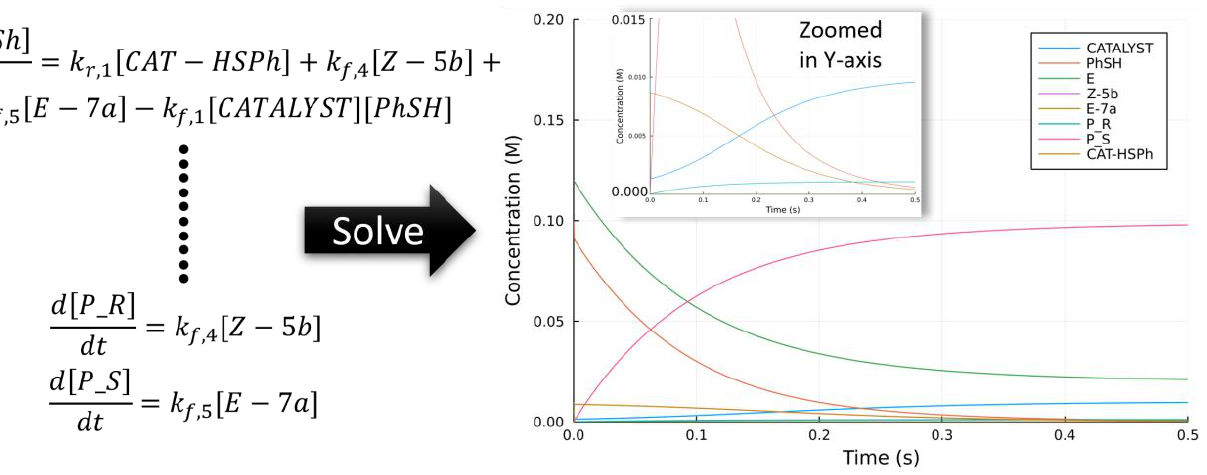
Figure 6. Solving a system of coupled ODE to obtain the concentration of all species over time (only